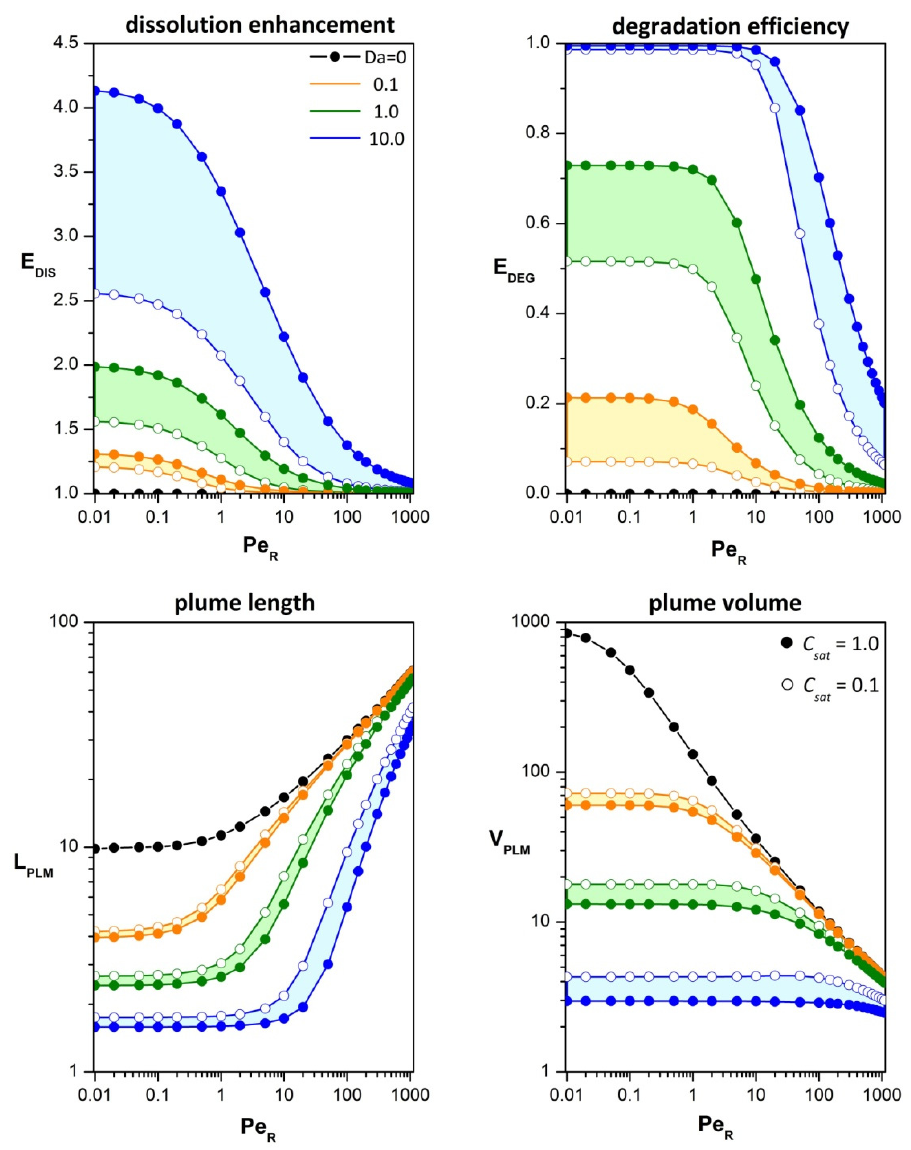
Figure 6. Effects of advection (Pe), uptake (Da) and saturation ( C sat ) on characteristic metrics of the nutrient field: dissolution enhancement ( E dis ), degradation efficiency at r = 3 ( E deg ), plume length ( L plm ), and plume volume ( V plm ). The detection threshold is C det = 0.1, and the saturation threshold is C sat = 1 for filled circles (unsaturable uptake) and C sat = 0.1 for open circles. The color shading highlights the saturation impact on each metric for three Damkohler numbers: Da = 0.1 (yellow), Da = 1 (green), and Da = 10 (cyan).